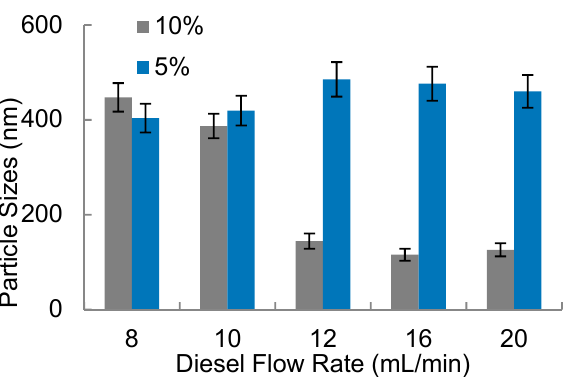
Figure 7. Vortex microfluidic device: ( a ) device geometry; ( b ) fabricated device in LTCC.